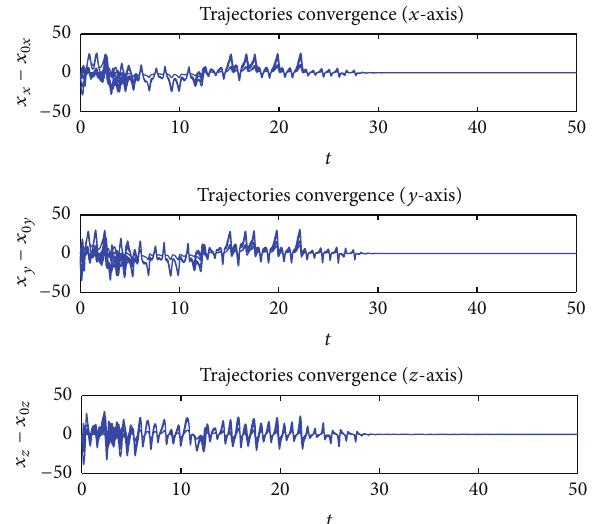
Figure 3: Trajectories convergence of 10 nodes with only one node informed by controllers